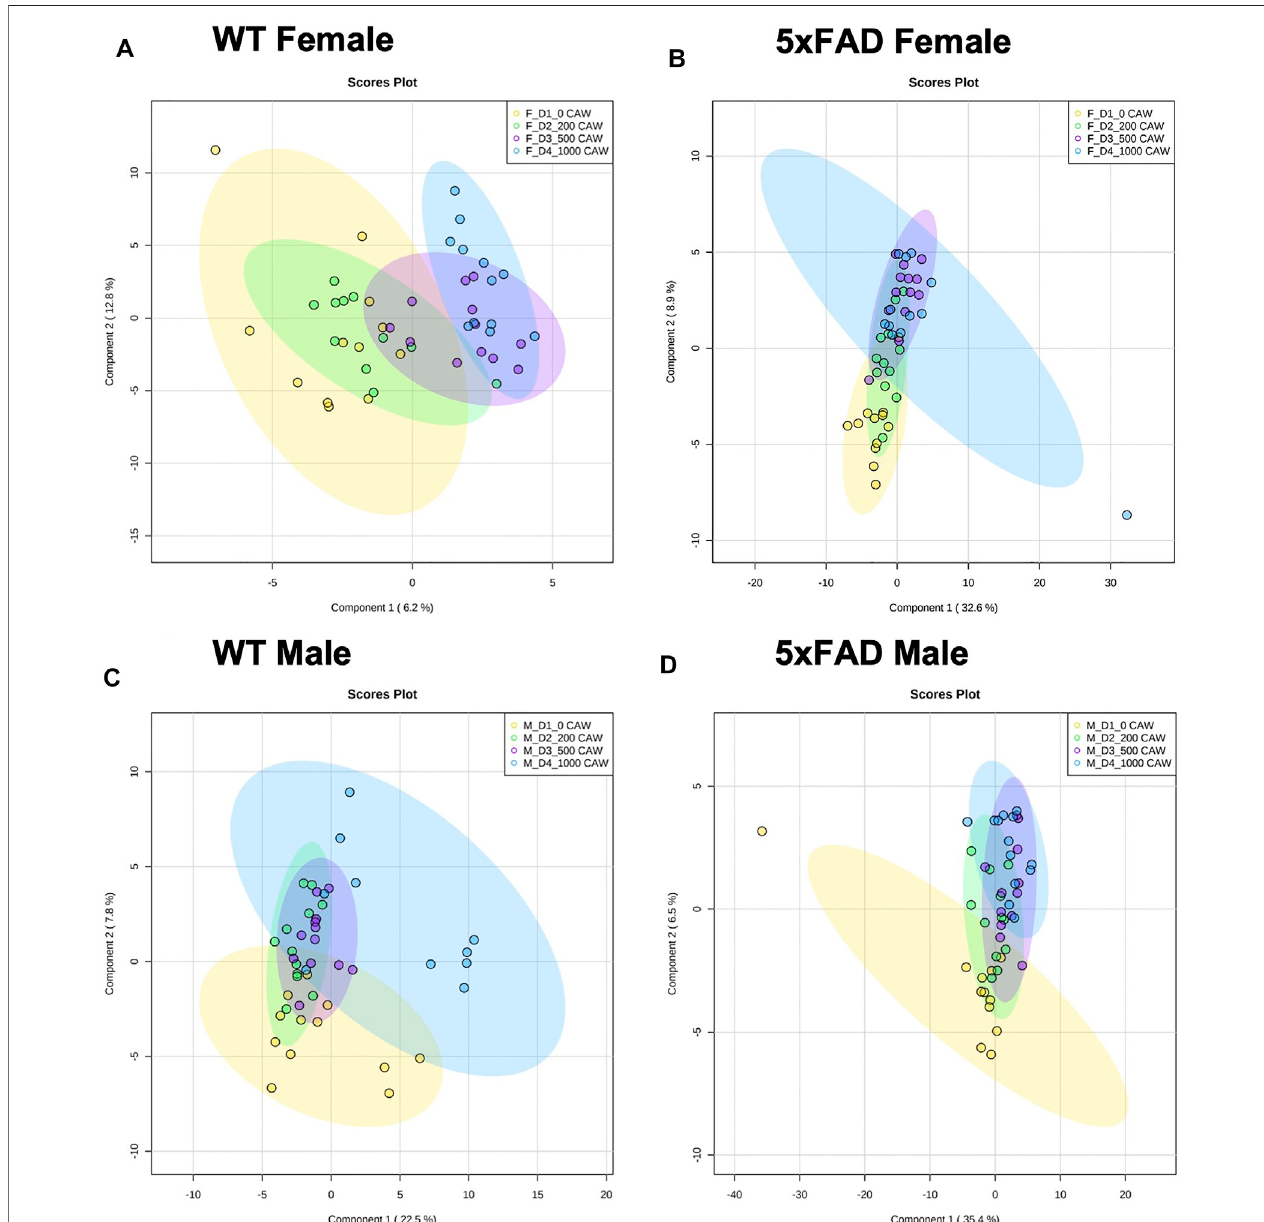
FIGURE4| PLS-DA plotcomparing corticalmetabolomic pro fi lesofmale andfemale 5xFADand wild-type (WT)mice treatedwithCAW 0(D1),200(D2),500(D3), or 1,000 (D4) mg/kg.